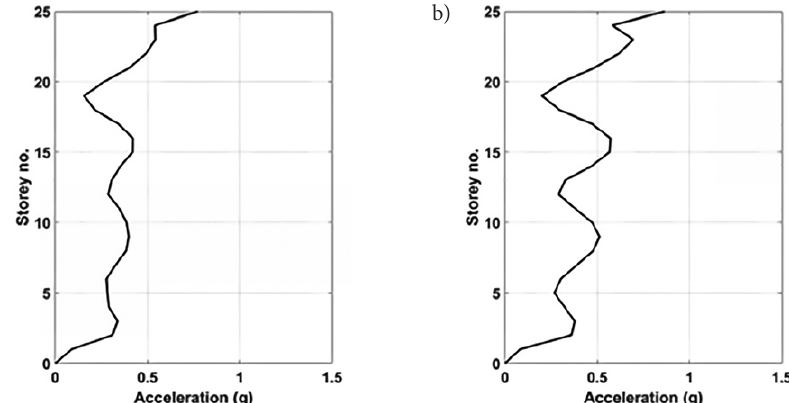
Figure 8. Peak story acceleration curves vs. story number under RS analysis in the: a – transverse direction and b –